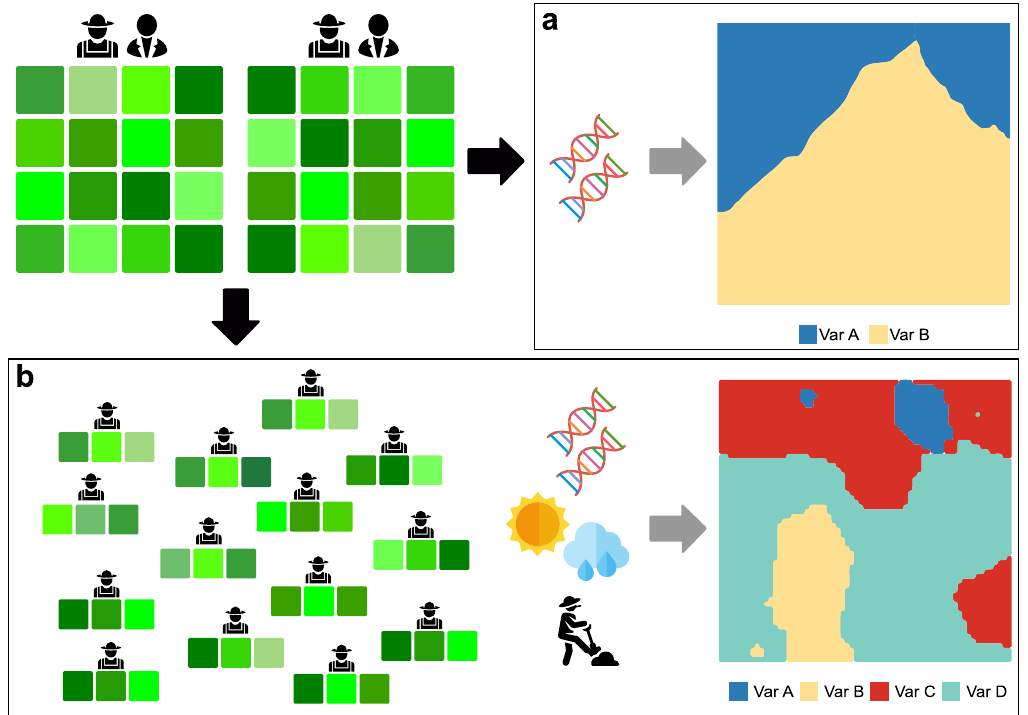
Fig. 1 A comparison of centralized versus decentralized breeding approaches. Centralized breeding ( a ) derives recommendations from breeders ’ evaluation and possibly participatory assessments in a limited set of stations, using genomics to accelerate the production of varieties that are eventually recommended with coarse spatial resolution. The plot shows the broad recommendation space of two hypothetical varieties, Var A and Var B. This system may become more ef fi cient if complemented by 3D-breeding ( b ), a decentralized approach where the best candidate genotypes are tested by farmers in small, blinded and randomized sets. 3D-breeding produces scalable solutions that can be linked to genomics, farmers ’ knowledge and environmental data, to enhance the local adaptation of the resulting varieties and tailor their recommendation to the landscape. This is represented in the plot to the right by the precise recommendation space of hypothetical varieties Var A, Var B, Var C and Var D.